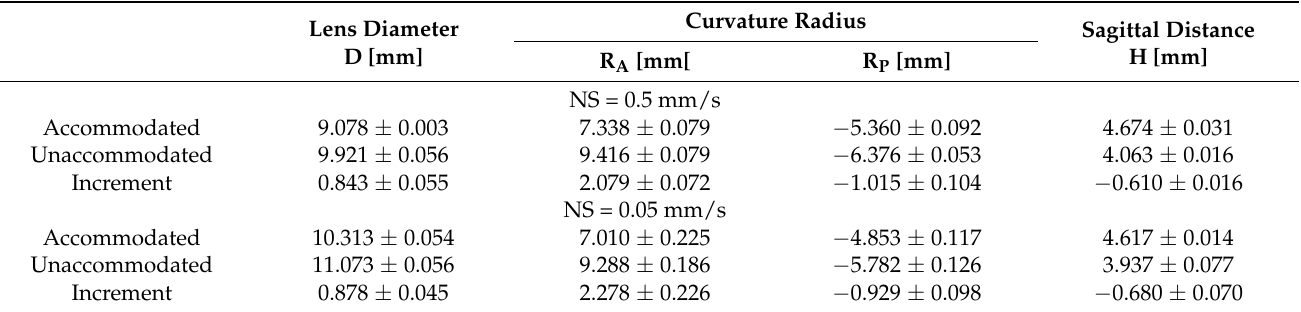
Table 1. Deforming properties of ALC from